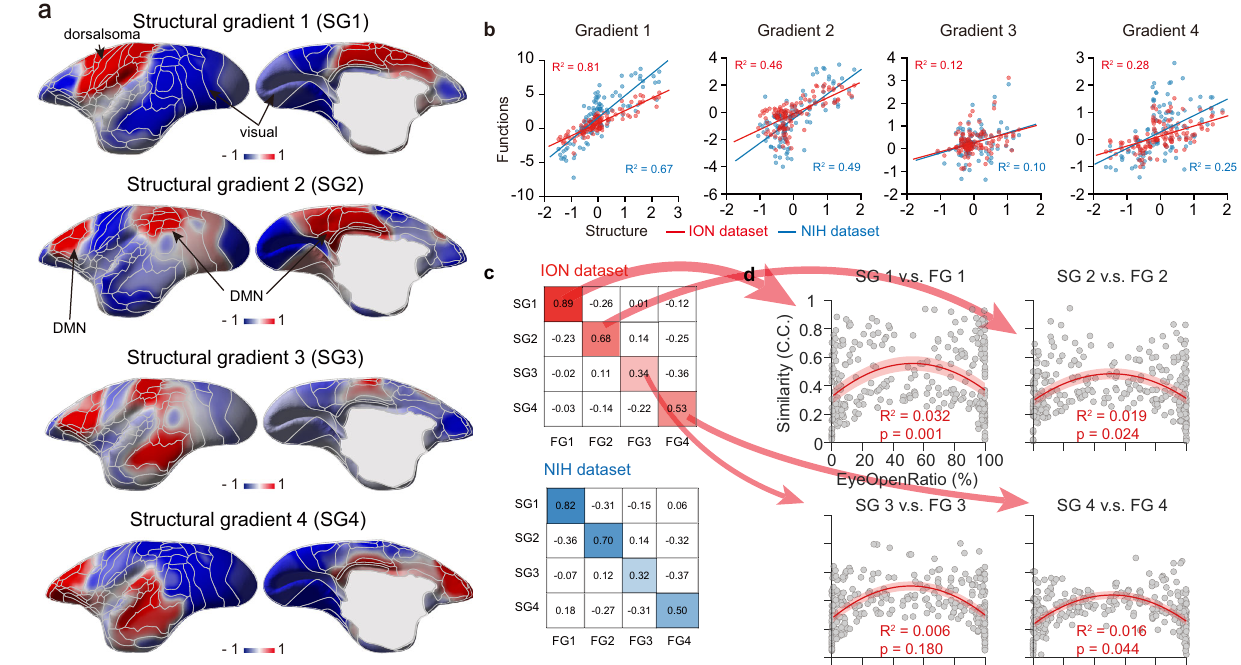
Fig.2|Structurebasisoffunctionalconnectivitygradientsinmarmoset.a First four gradients of marmoset structure connectivity based on marmoset brain connectivity atlas 23 . Areal borders were based on the Riken Brain/MINDS cor- ticalparcellation 70 .SG,structuralgradient. b Topographicalsimilaritybetween structure and function gradients (two-tailed t -test). Each dot represented a brain region. c High similarity (C.C., Pearson ’ s correlation coef fi cients)